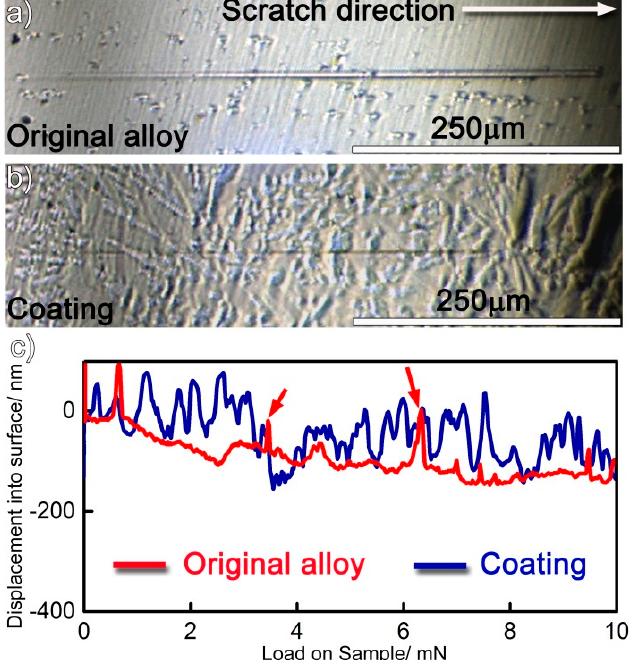
Figure 11. ( a , b ) Nanoscratch impressions on the original alloy and coating, and ( c ) scratch depth profile vs normal applied load